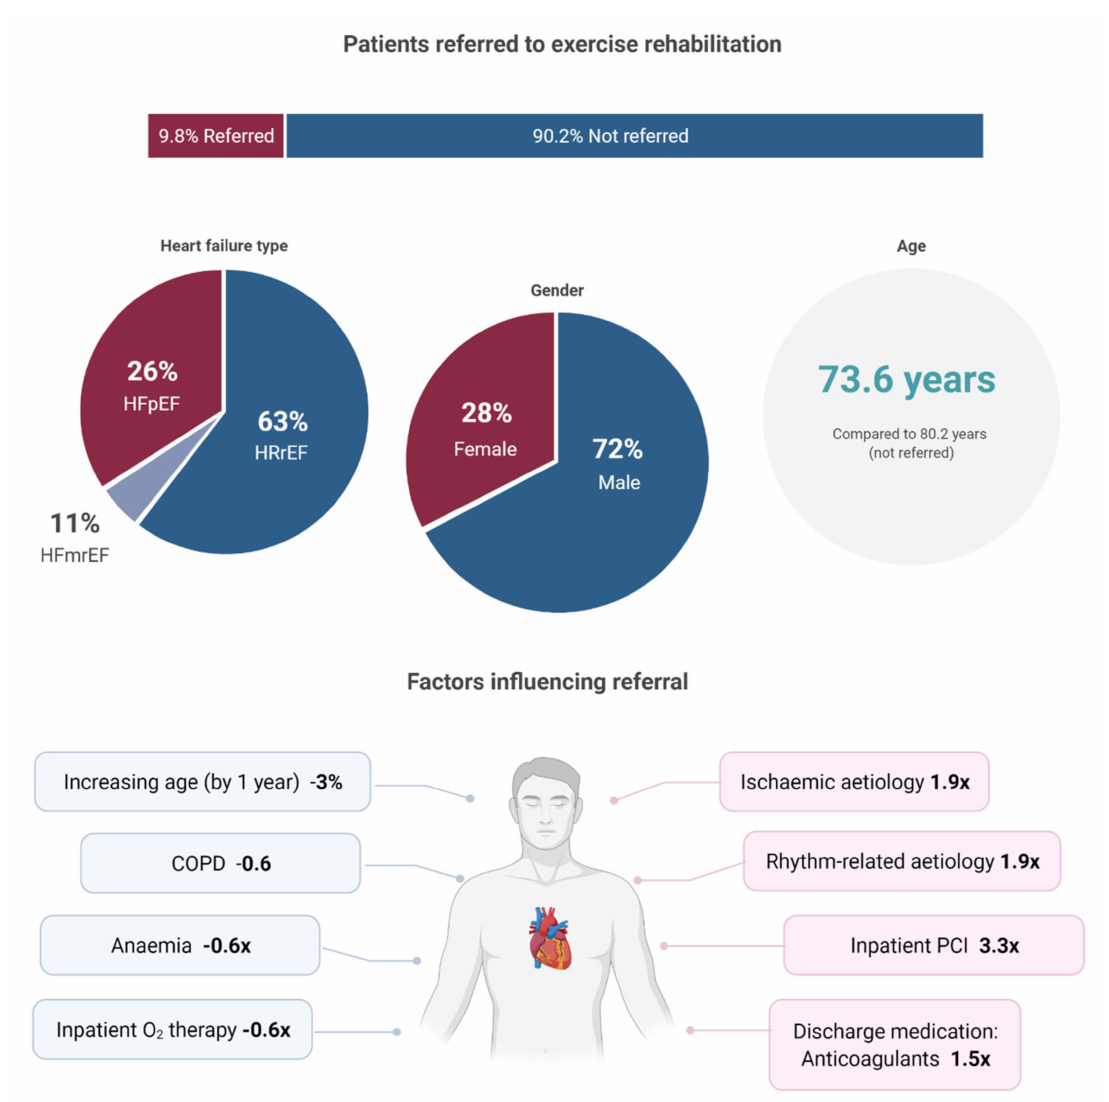
Figure 2. Central illustration of key findings (created with BioRender.com). Bottom image: Factors which decreased the odds of referral are shown in blue, while factors that increased the odds of referral are shown in pink. The multiplication factor is derived from the odds ratios reported in Table 2, Section 3.3. HFpEF; Heart failure with preserved ejection fraction, HFrEF; Heart failure with reserved ejection fraction, HRmrEF; Heart failure with mid-range ejection fraction, COPD; Chronic obstructive pulmonary disease, PCI; Percutaneous coronary